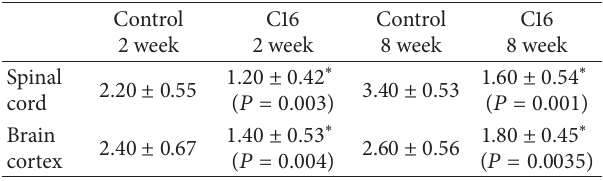
Table 1: Histopathological analysis of demyelination damage in spinal cord (S) and brain cortex (B) of C16 late treated